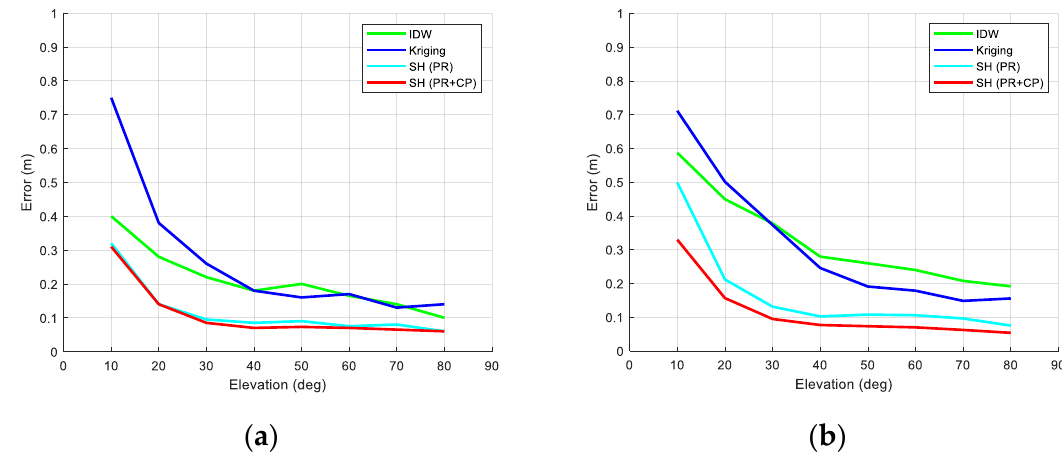
Figure 10. Residual error according to the elevation angle (simulation): ( a ) User 5; ( b ) Users 1–4 and 6–9.